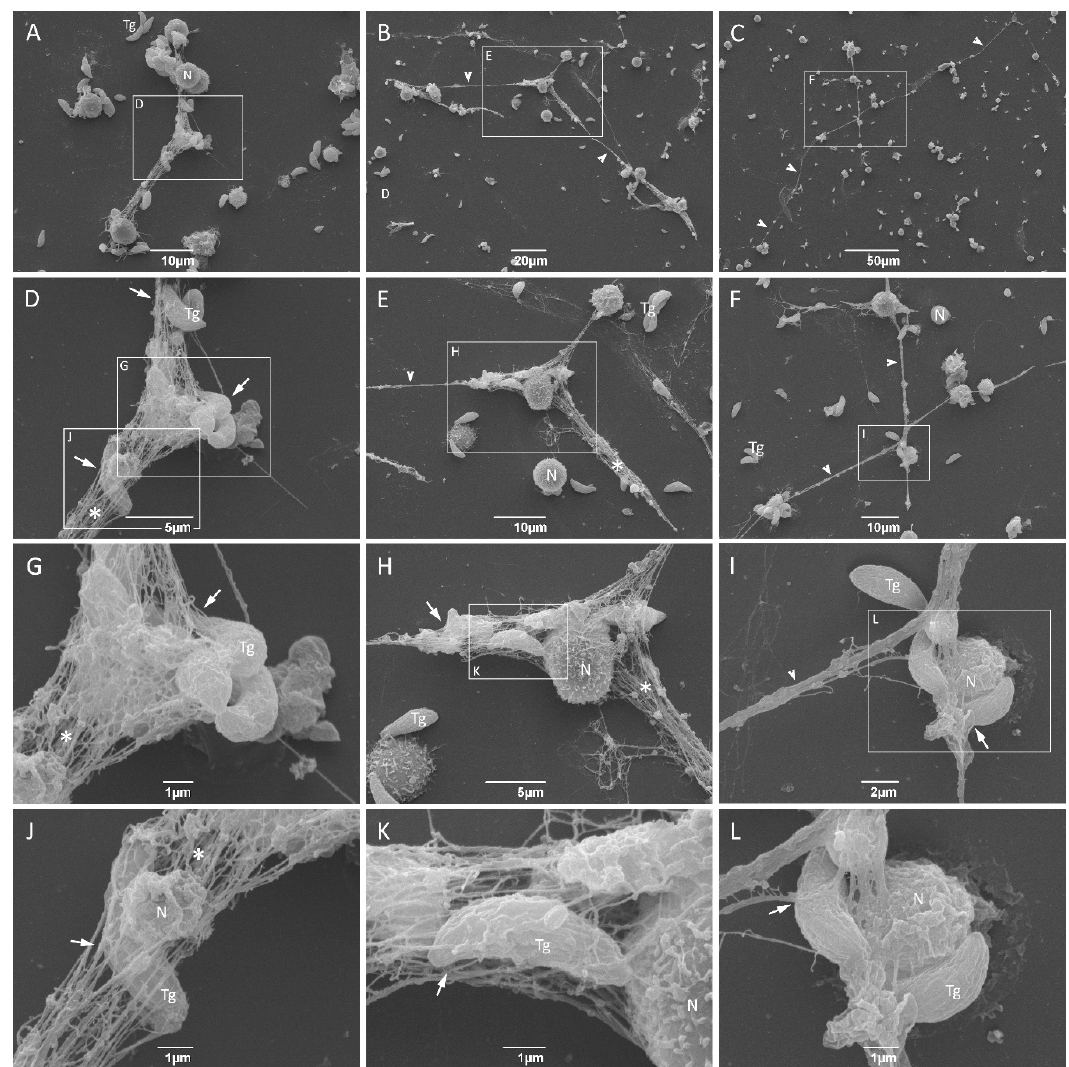
Figure 3. Ultrastructural aspects of T. gondii and cat NET interactions. Neutrophils were incubated for 180 min with tachyzoites from RH strain (5:1 parasites:neutrophil ratio), fixed and processed for scanning electron microscopy ( A ‐ L ). Strands (arrowheads) or networks (asterisks) of NET can be seen entrapping tachyzoites of T. gondii (arrows). Selected areas indicated by rectangles are zoomed in the picture bellow. Tg = T. gondii ; N = neutrophil.